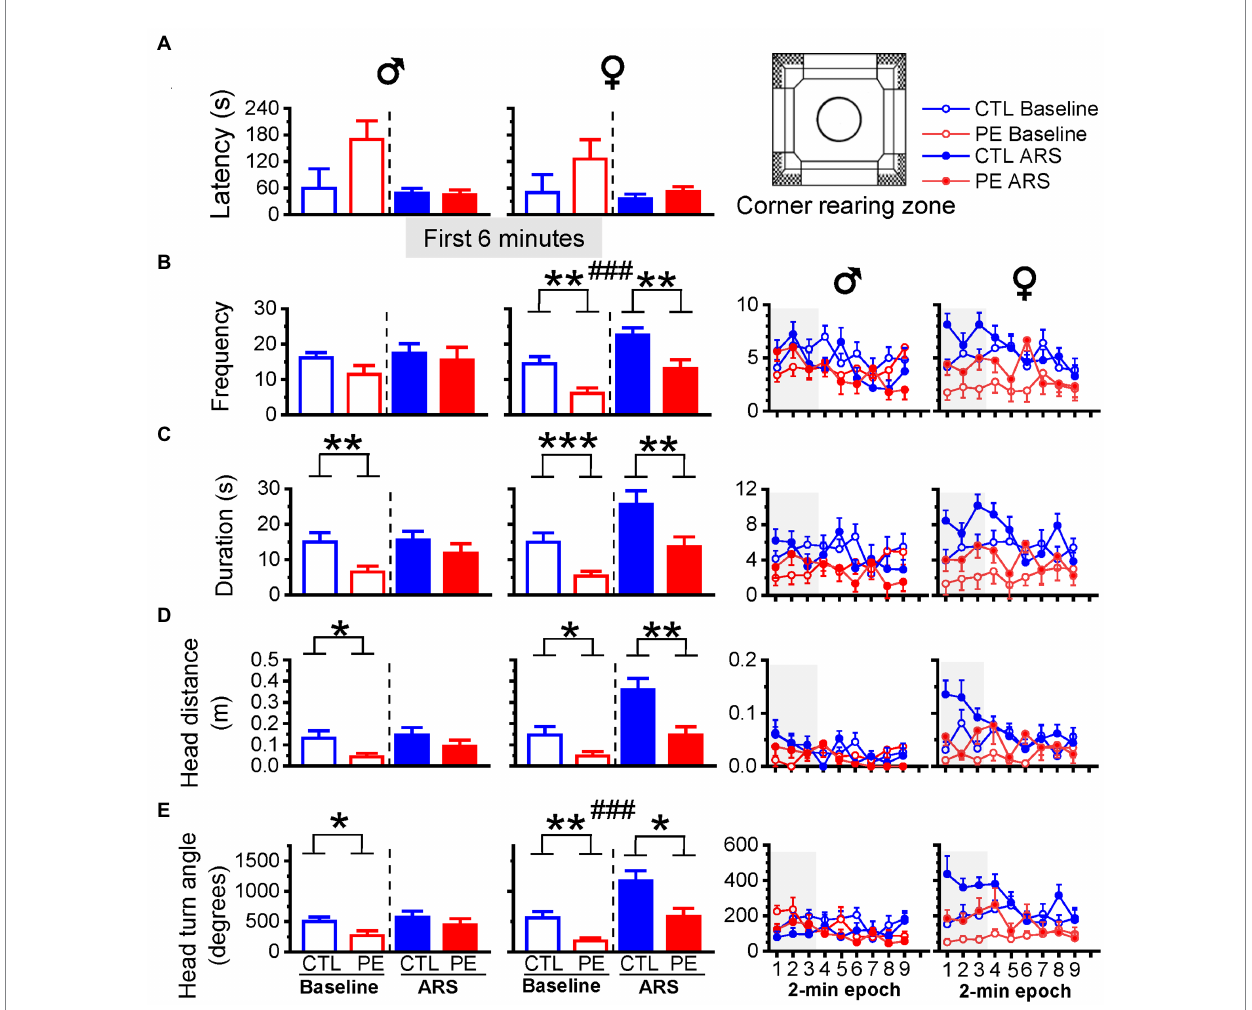
FIGURE 7 Effects of prenatal ethanol exposure (PE) and acute restraint stress (ARS) on rearing behaviors in the corner in the first 6 min of the OF task. In male rats, PE reduced the duration, head distance, head turn angle, indicating increased anxiety-like behavior (C–E) . In female rats, PE reduced the frequency, duration, head distance and the head turn angle under baseline condition and after ARS (B–E) . Prenatal ethanol did not impact the latency in males and females (A) . The right panels display the frequency, duration, head movement, and head turn angle of rearing in 2-min epoch. Data are represented as Mean ± SEM. * p ≤ 0.05, ** p < 0.01, *** p < 0.001, control vs. PE. ### p < 0.001, baseline condition vs.